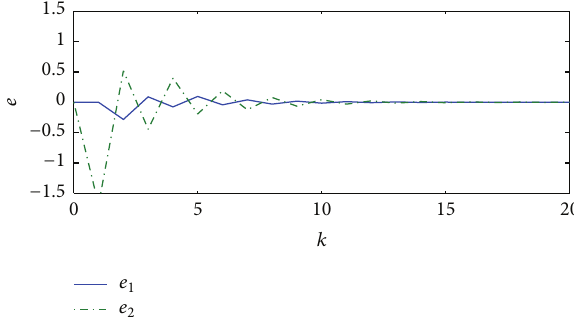
Figure 2: State of the fuzzy descriptor system.